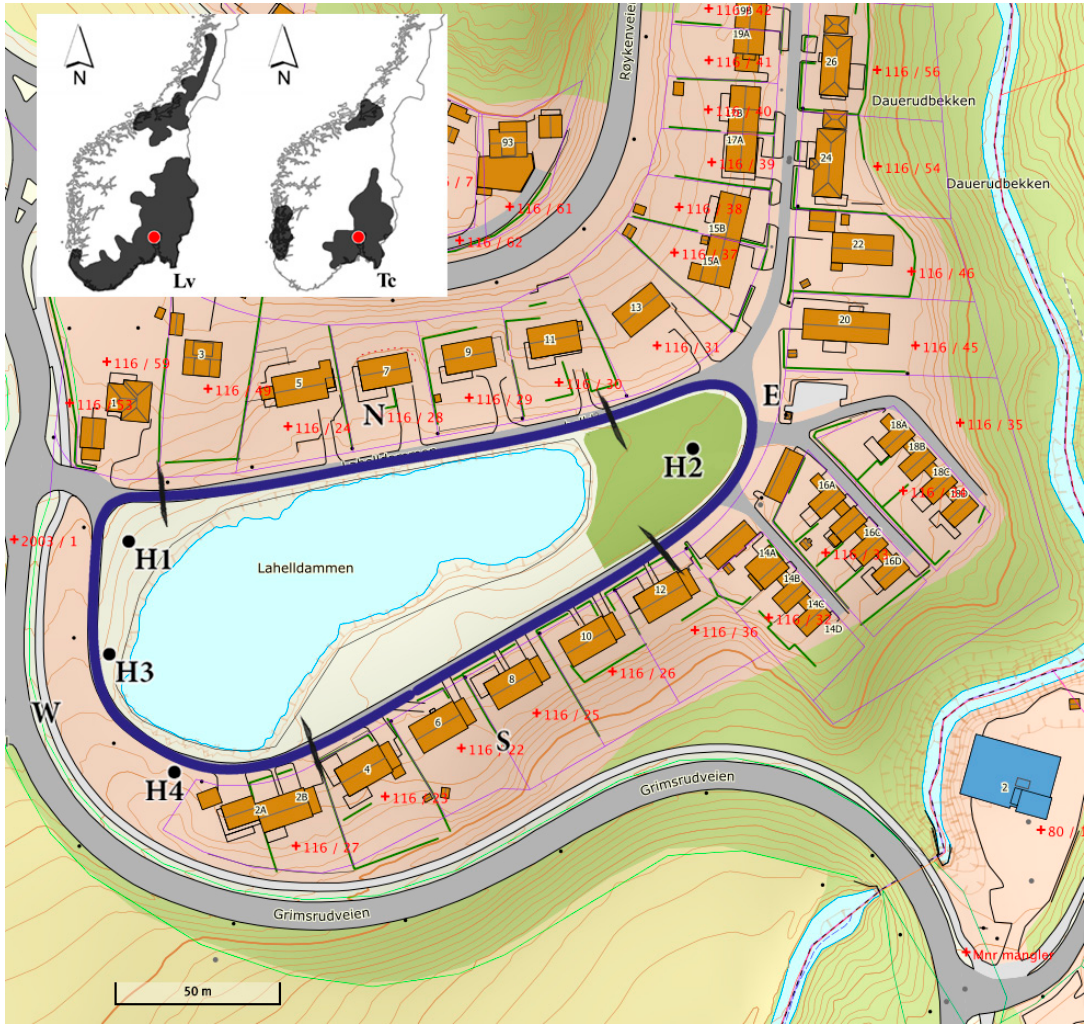
Figure 1. Map of the pond at Lahelldammen (UTM WGS84 33N 0236699 33S 6630232) in Southeastern Norway, with the four newt hotels (dots, nos. H1–4), zones (North, East, South and West), and the route for observation (Lahelldammen road). The distribution (gray) areas of Great Crested Newt (Tc right) and Smooth Newt (Lv left) in Norway are given in the maps in the upper part of the figure. The red point shows the location of Lahelldammen.